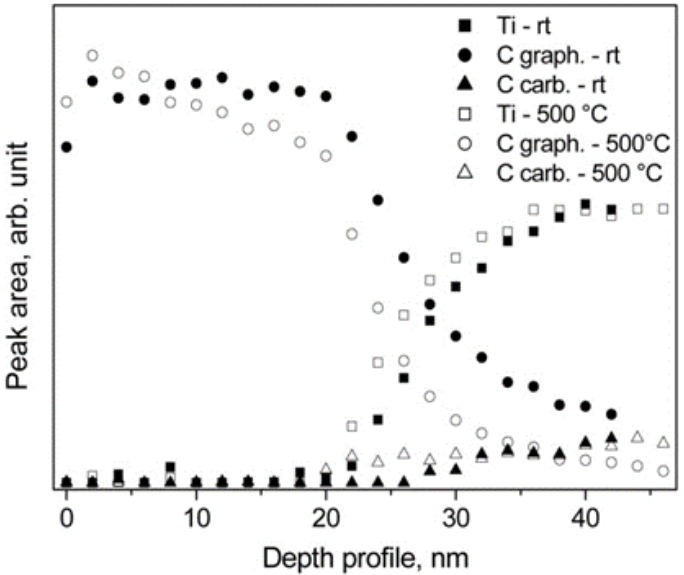
Figure 21. XPS depth profiles of the Ti 99.99 + sample covered with carbon at room temperature (rt) and after heating at 500 °C [29].